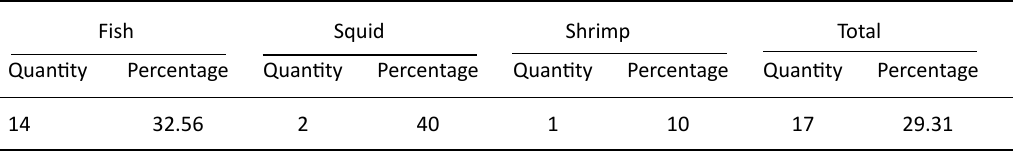
Table 4. Antimicrobial susceptibility of Salmonella spp. in raw seafood Fish